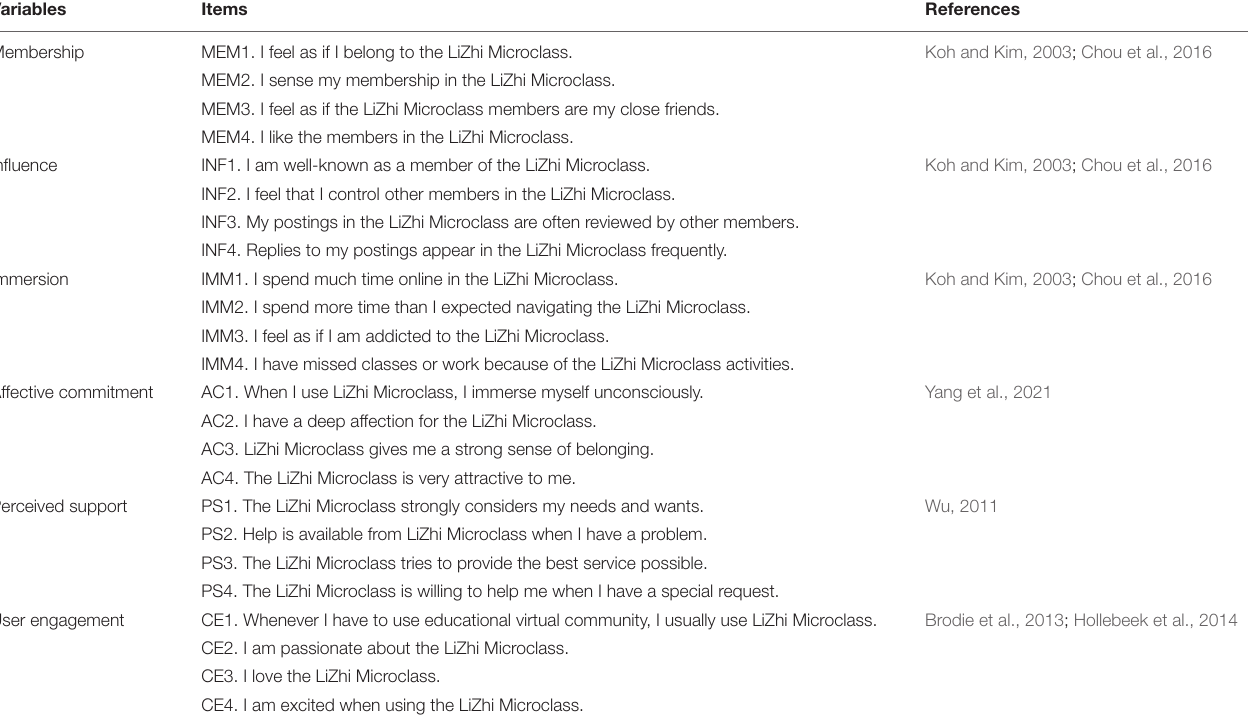
TABLE 2 | Variables and measurement